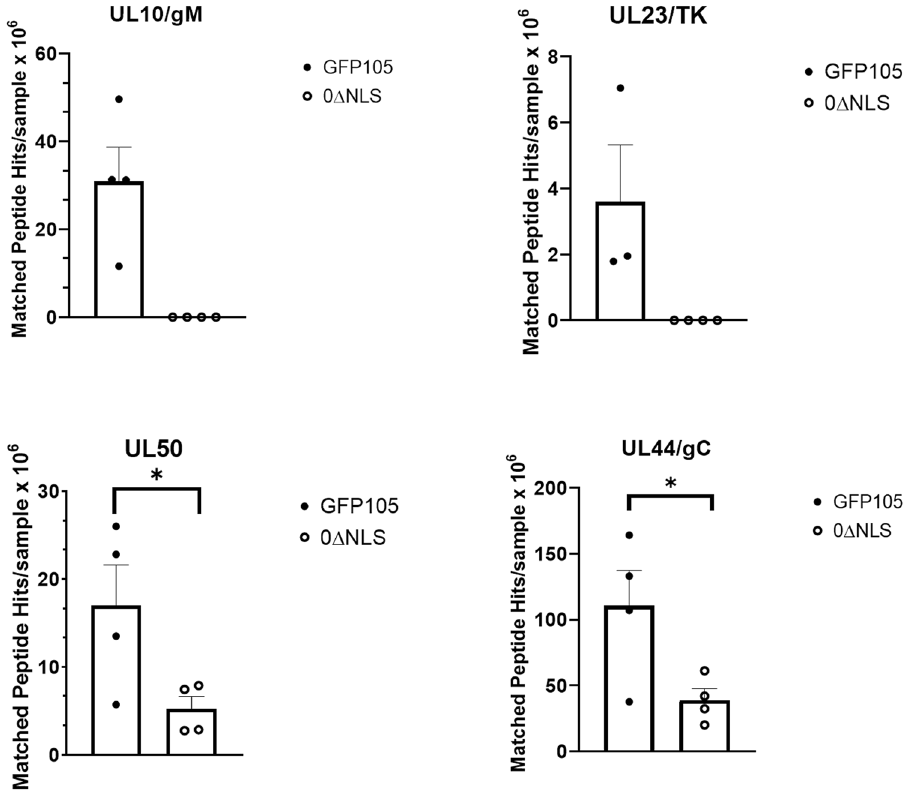
Figure 6. HSV-1 gM and TK are recognized by antiserum from GFP105- but not 0∆NLS-vaccinated mice. Serum (n = 4 samples/group) from GFP105- and 0∆NLS-vaccinated mice was used to immunoprecipitate virus-encoded proteins from HSV-1-infected Vero cell lysates. Precipitated proteins were analyzed by mass spectrometry. HSV-1 proteins were identified via cross-referencing derivative peptide ions with a reference sequence data base. The bars represent the mean matched peptide abundance/intensity per protein ± SEM, * p < .05 comparing the two groups as determined by multiple t-test using the Holm-Sidak